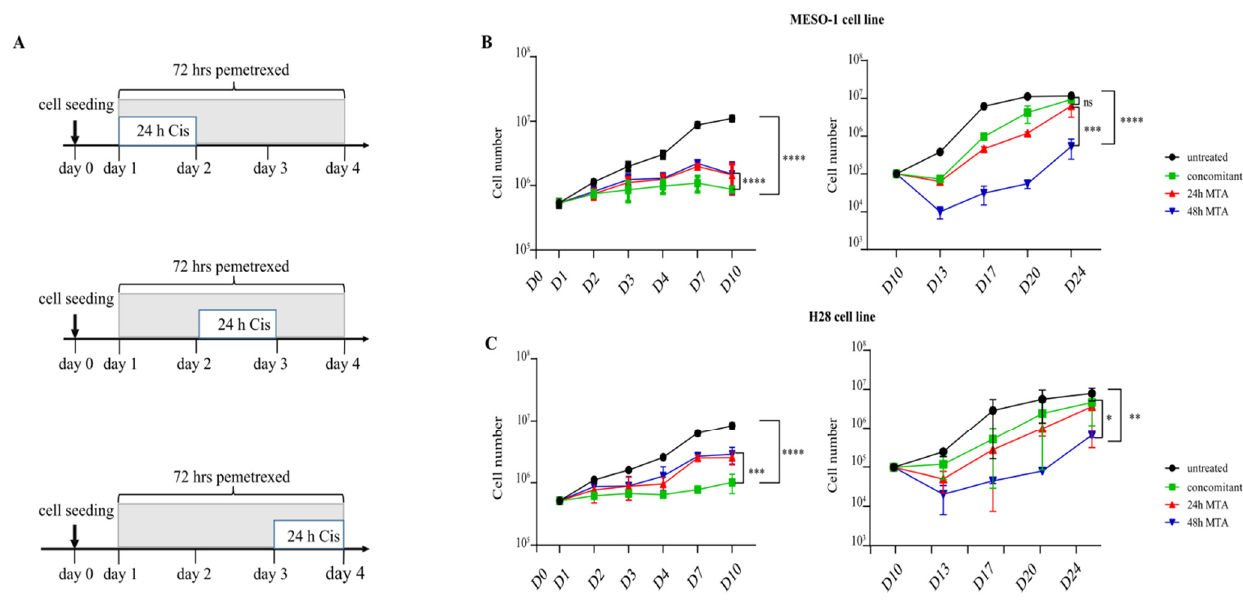
Figure 1. A schedule-dependent treatment plan improves the therapeutic efficacy of MTA-cisplatin combination therapy. ( A ) Schematic representation of the three treatment regimens, which differ in the duration of MTA pretreatment before the addition of cisplatin (see text for details). ( B ) Growth curves of MESO-1 ( n = 3) cells during the treatment (d1–d4) and the recovery phase (d10–d24). Cells exposed to the indicated treatment regimen were harvested at day 10, reseeded, and cell numbers were determined at the indicated time points. Data represent means of three independent experiments, and bars indicate standard deviations. Two-way ANOVA was used to compare different treatment groups (ns p > 0.05 (not significant), and **** p < 0.0001). ( C ) Growth curves of H28 ( n = 2) cells during treatment phase (d1–d4) and recovery phase (d10–d24). Two-sided student’s t test was